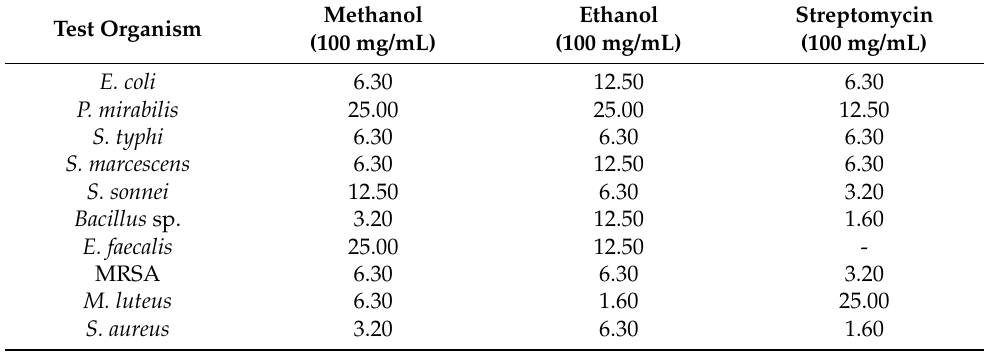
Table 3. Breakpoints of S. glauca extract.